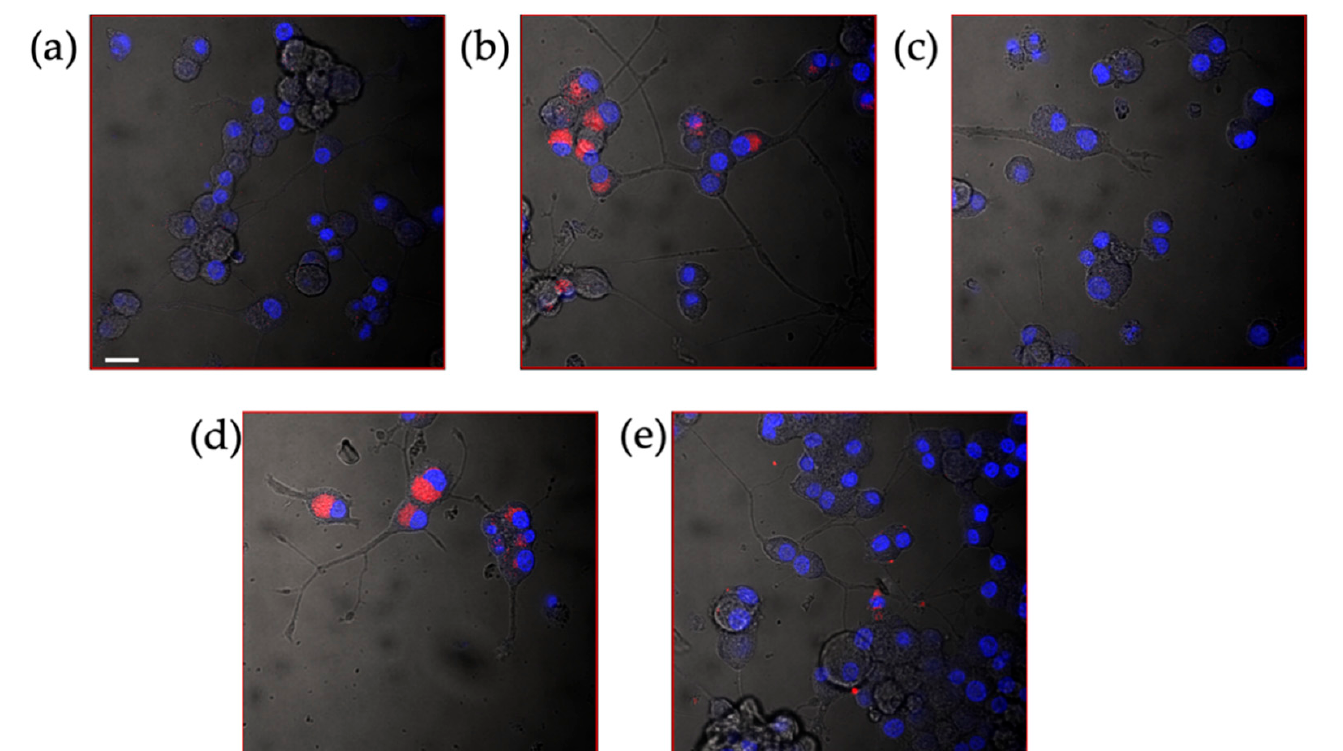
Figure 11. LSM-merged micrographs of bright field (in grey) and fluorescence (blue: Hoechst33342 nuclear staining, λ ex/em = 405/425–450 nm; red: Rhodamine B, λ ex/em = 543/550–600 nm) of d-PC12 cells untreated (negative control, ( a ) and after 2 h of treatment with: 4 µM RhB (positive control, ( b ), 3 mg/mL bare PNP (positive control, ( c ), 3 mg/mL RhB loaded-PNP ( d ), 3 mg/mL RhB grafted-PNP ( e ). Scale bar 20 µ